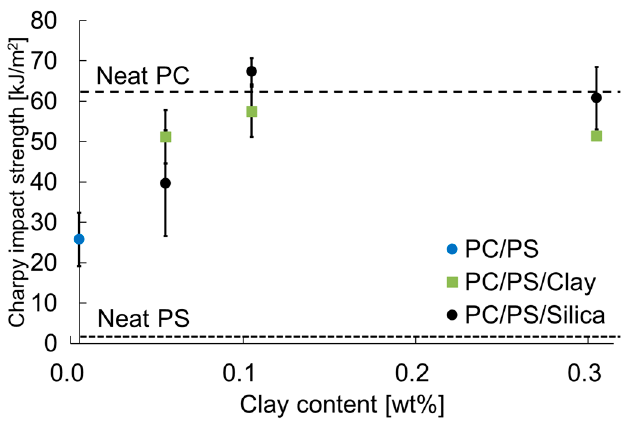
Figure 10. Nano-filler content dependence of the Charpy impact